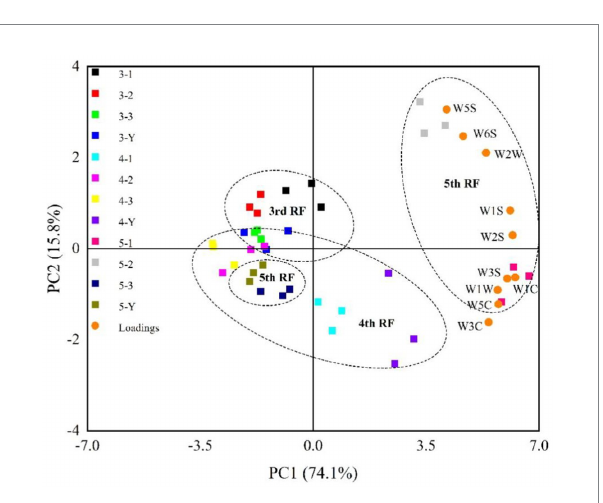
FIGURE 4 Principal component analysis (PCA) loadings plot of sensors of different quality grades of base